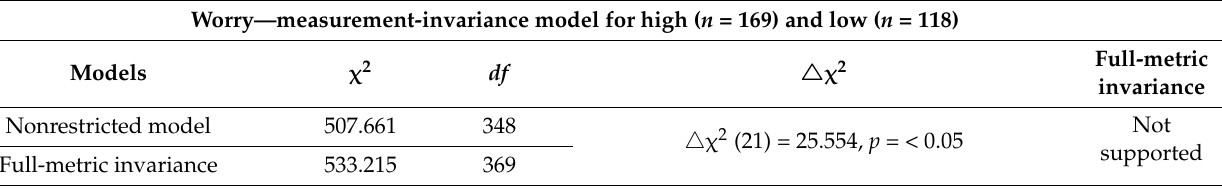
Table 5. Summary of multigroup invariance test results